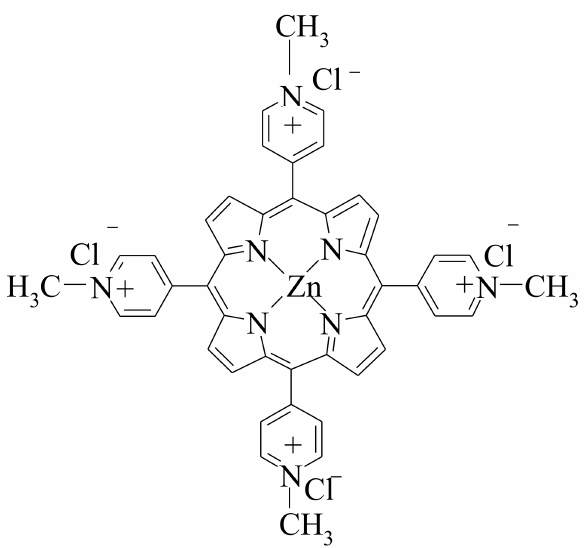
Figure 1. Water soluble (Zn-TNMPyP) metalloporphyrin used for incorporation [70]).